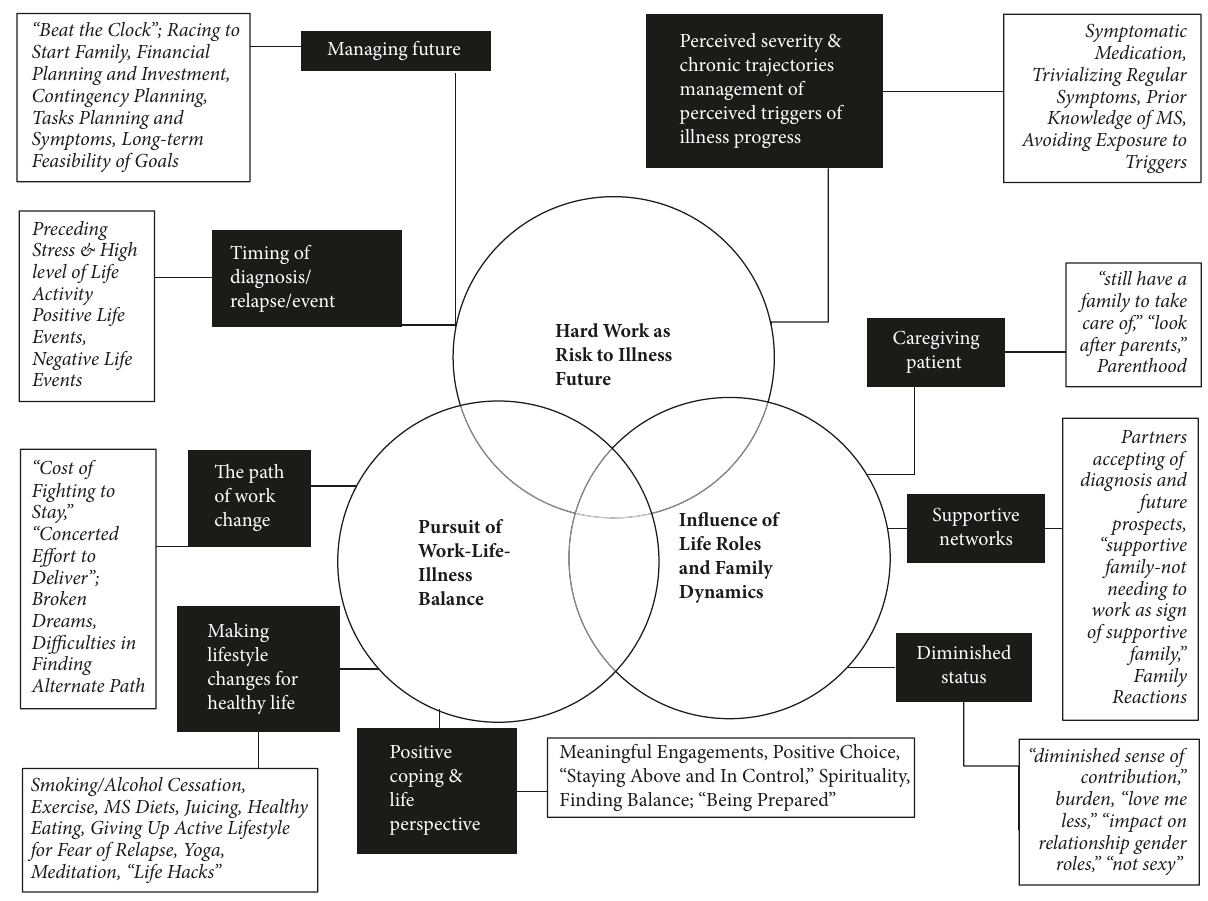
Figure 1: Codes and interpretive